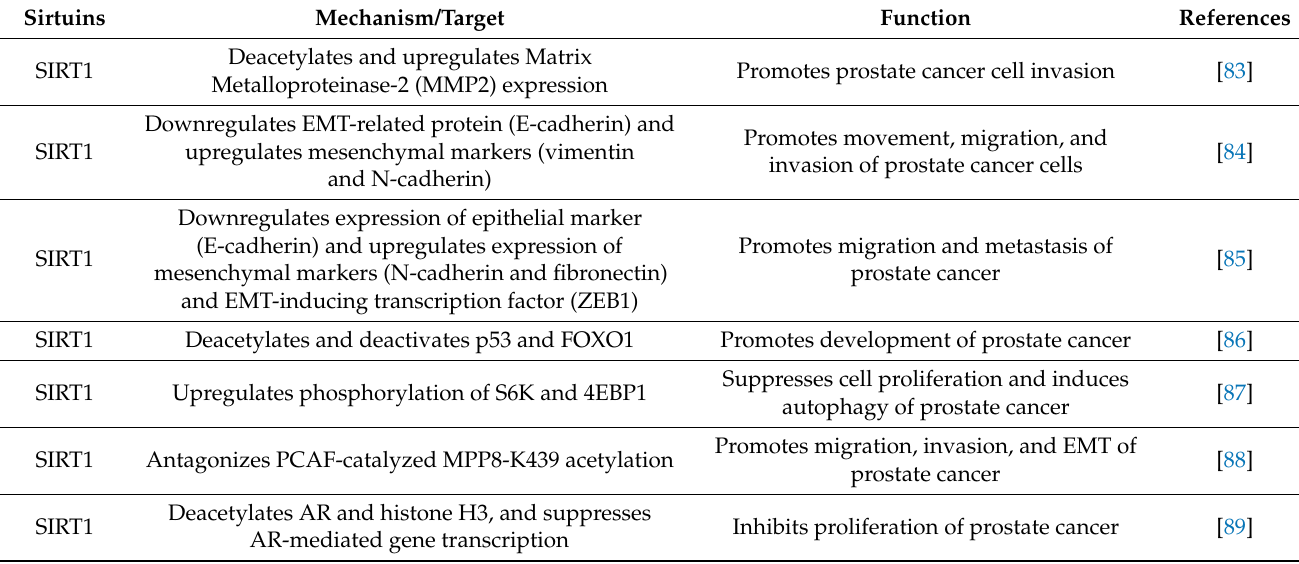
Table 2. Mechanistic Roles of Sirtuins (SIRT1–7) in Prostate